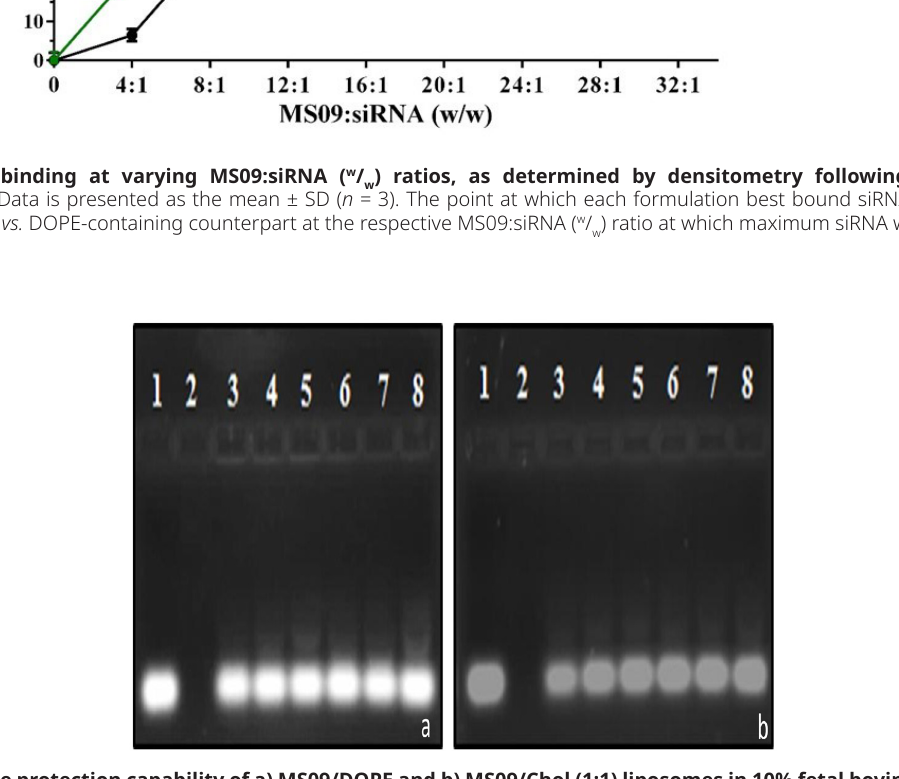
Figure 4. Nuclease protection capability of a) MS09/DOPE and b) MS09/Chol (1:1) liposomes in 10% fetal bovine serum for 4 h at 37 ° C. In each gel, lane 1 contained undigested siRNA, lane 2, serum-digested siRNA and lanes 3–8, serum-exposed lipoplexes at varying MS09:siRNA (12:1 – 32:1 w / ) ratios. w